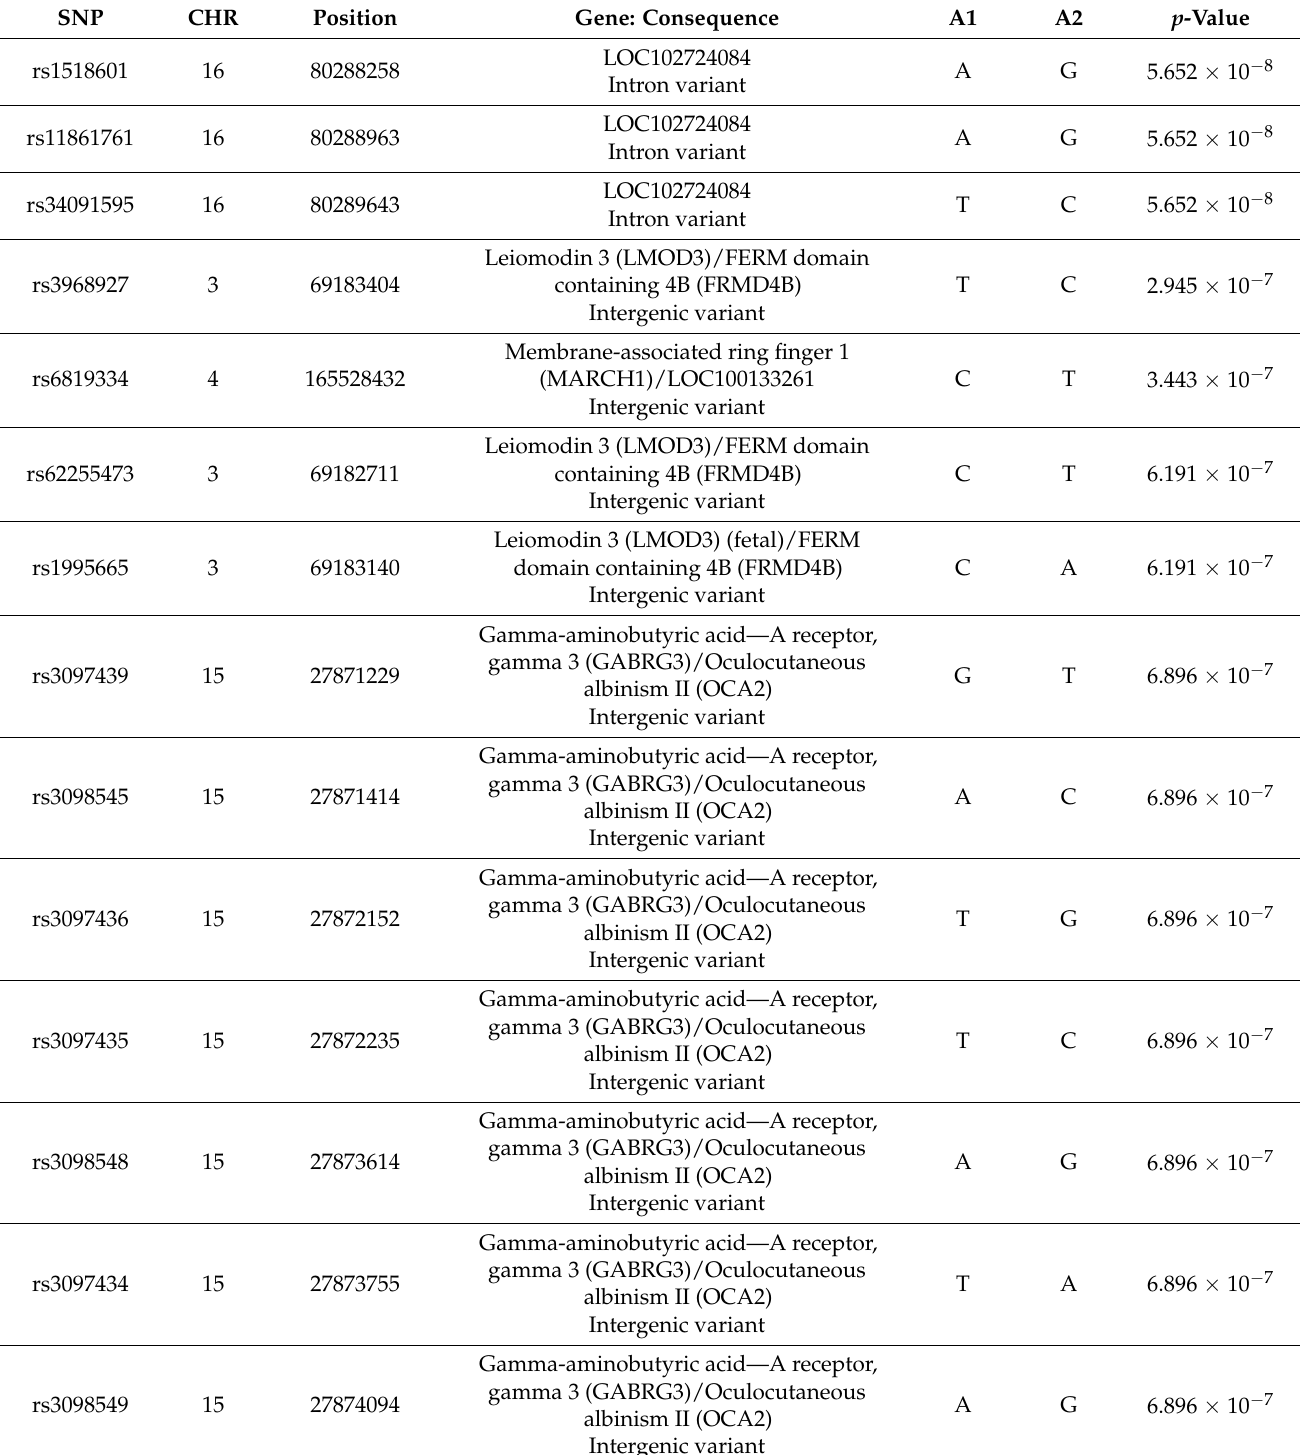
Table 2. Genome-Wide Association study results: 30 SNPs with the lowest p